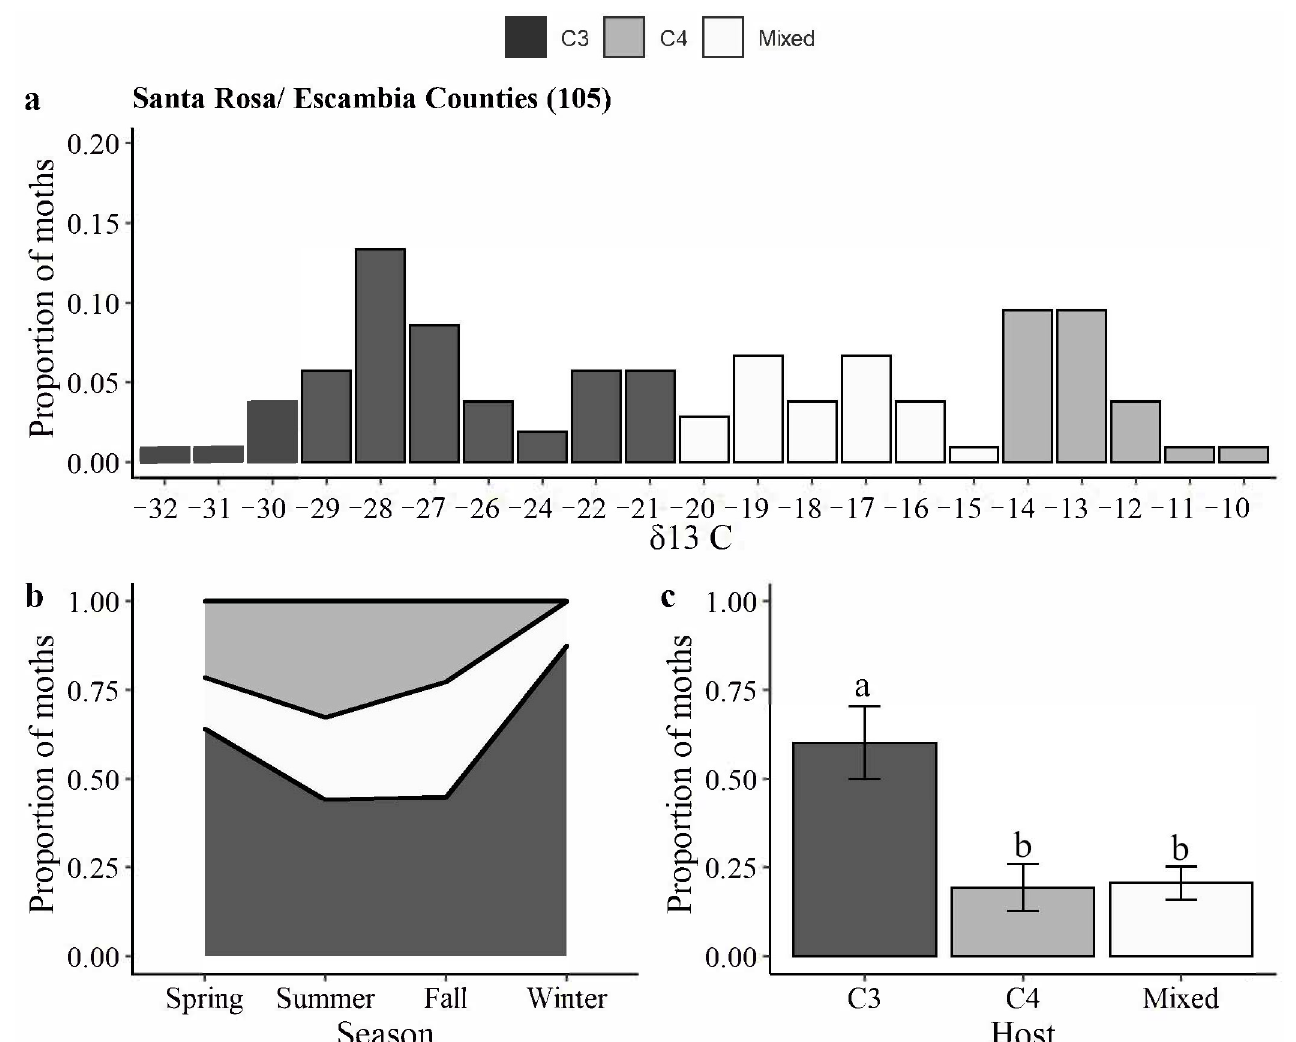
Figure 3. Carbon isotopic analysis of H. zea moths trapped in commercial fields in Santa Rosa/Escambia counties: ( a ) distribution of δ 13 C values from H. zea wings ( y -axis indicates the proportion of samples with a given δ 13 C value); ( b ) proportion of insects developed on C3, C4, or mixed (both C3 and C4) host plants over the seasons; and ( c ) proportion of insects developed on C3, C4, or mixed host plants. Bars with the same le tt ers are not signi fi cantly di ff erent ( p > 0.05, Wilcox test).